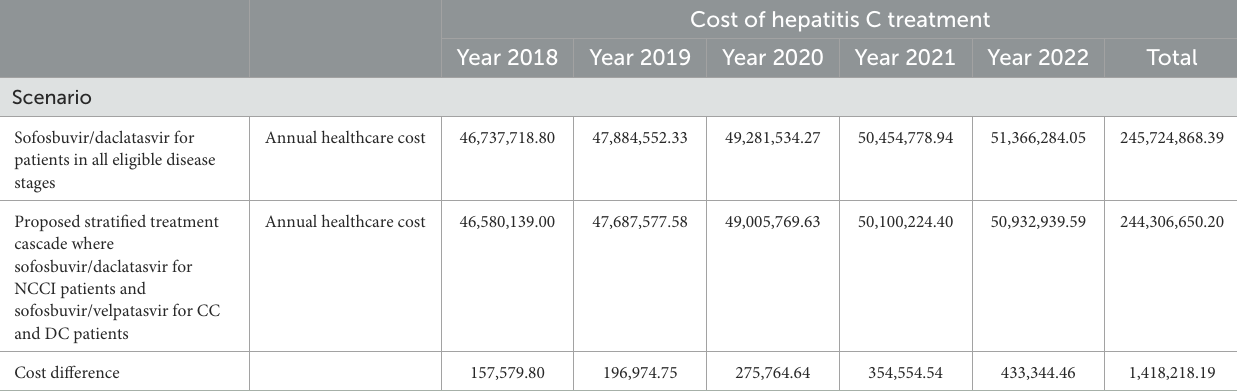
TABLE 3 Budget impact analysis over 5 years for treating chronic hepatitis C patients with sofosbuvir/daclatasvir (scenario A) and stratified treatment cascade which sofosbuvir/daclatasvir in pre-cirrhotic stage and sofosbuvir/velpatasvir in cirrhotic stage (scenario B; USD,